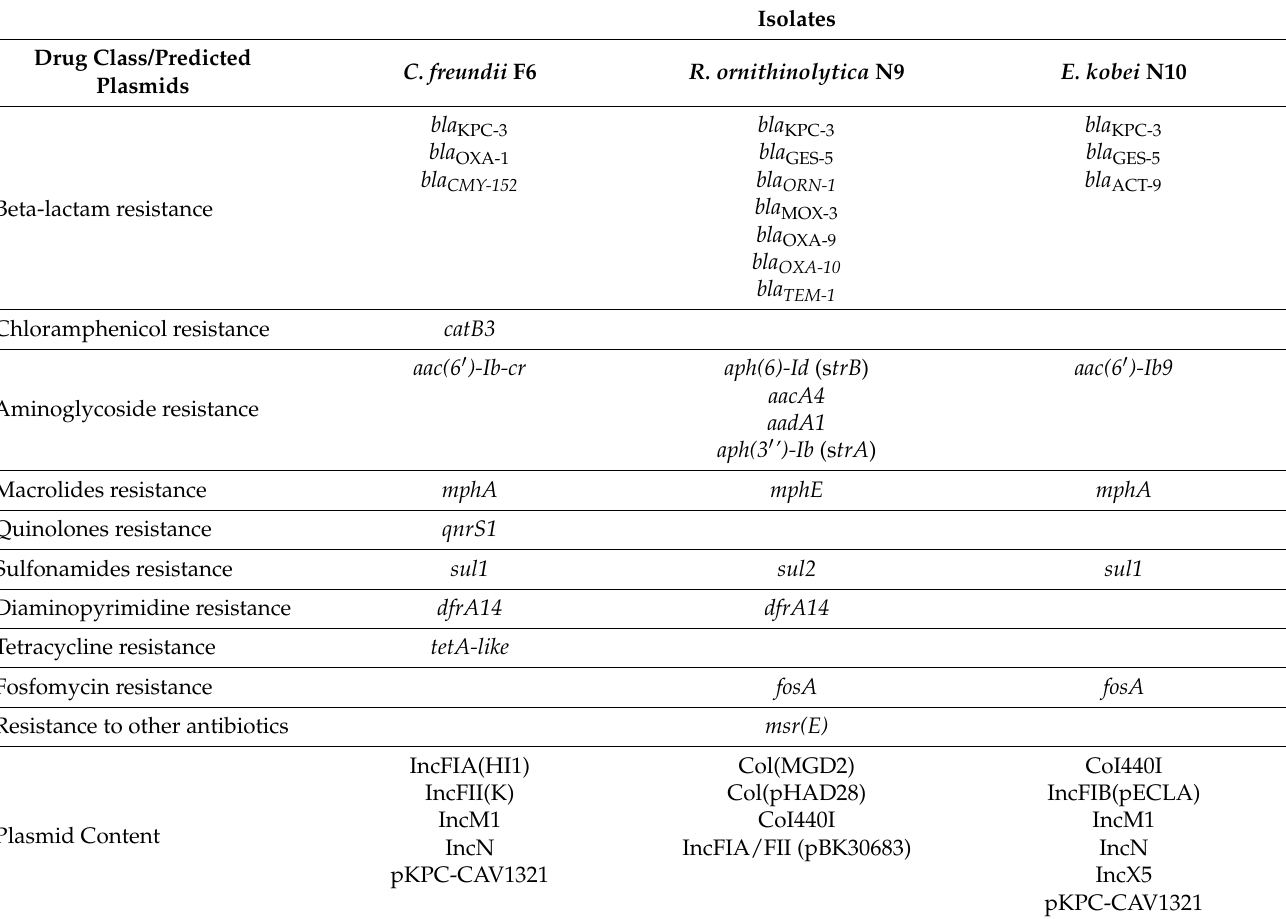
Table 3. Putative ARGs and plasmids predicted by CARD and PlasmidFinder, respectively, in CRE